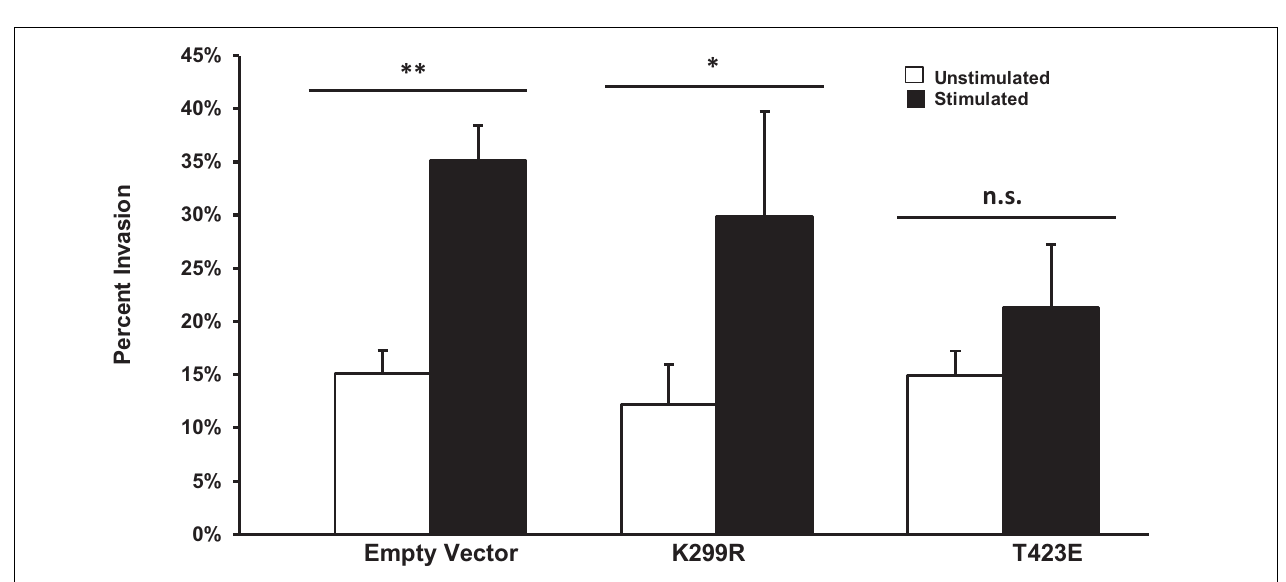
FIGURE 2 | Overexpression of integrin β 3 affects PAK1phosphorylation levels. When integrin β 3 is overexpressed in HT1080 cells, mechanical stimulation produces an increase in p-PAK1 levels, which suggests that integrin β 3 signaling is required for the activation of PAK1. The empty vector represents cells that have been mock transfected using GFP plasmid. ∗ P < 0.05 by the Student’s t -test; n = 3. Error bars represent the SEM.